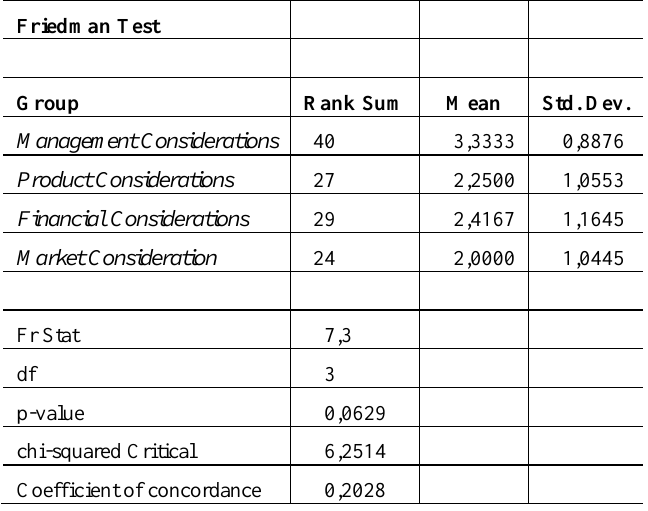
Table 1: The Friedman test